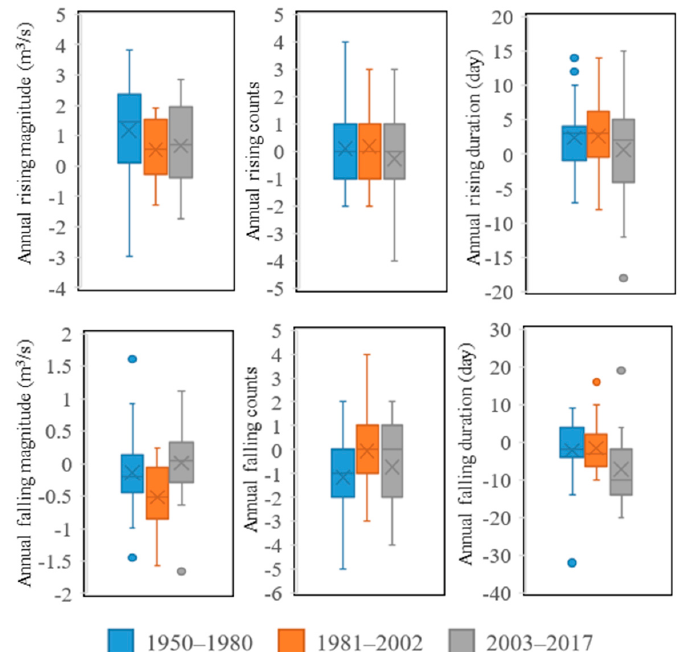
Figure 8. Boxplots of flow rising/falling characteristic difference between Yichang and Cuntan during May–June/October–November. The upper and lower parts of the boxes represent the 75th and 25th percentiles, respectively; the whiskers indicate the 90th and 10th percentiles; and the lines within the boxes are the median values.